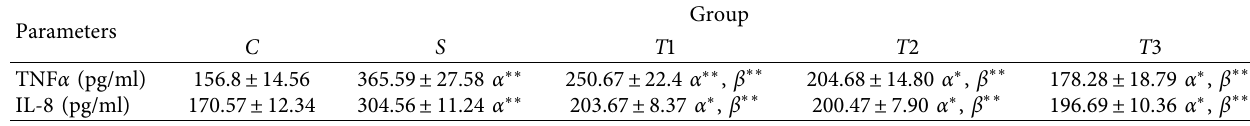
Table 3: Changes in proinflammatory markers in the study groups.